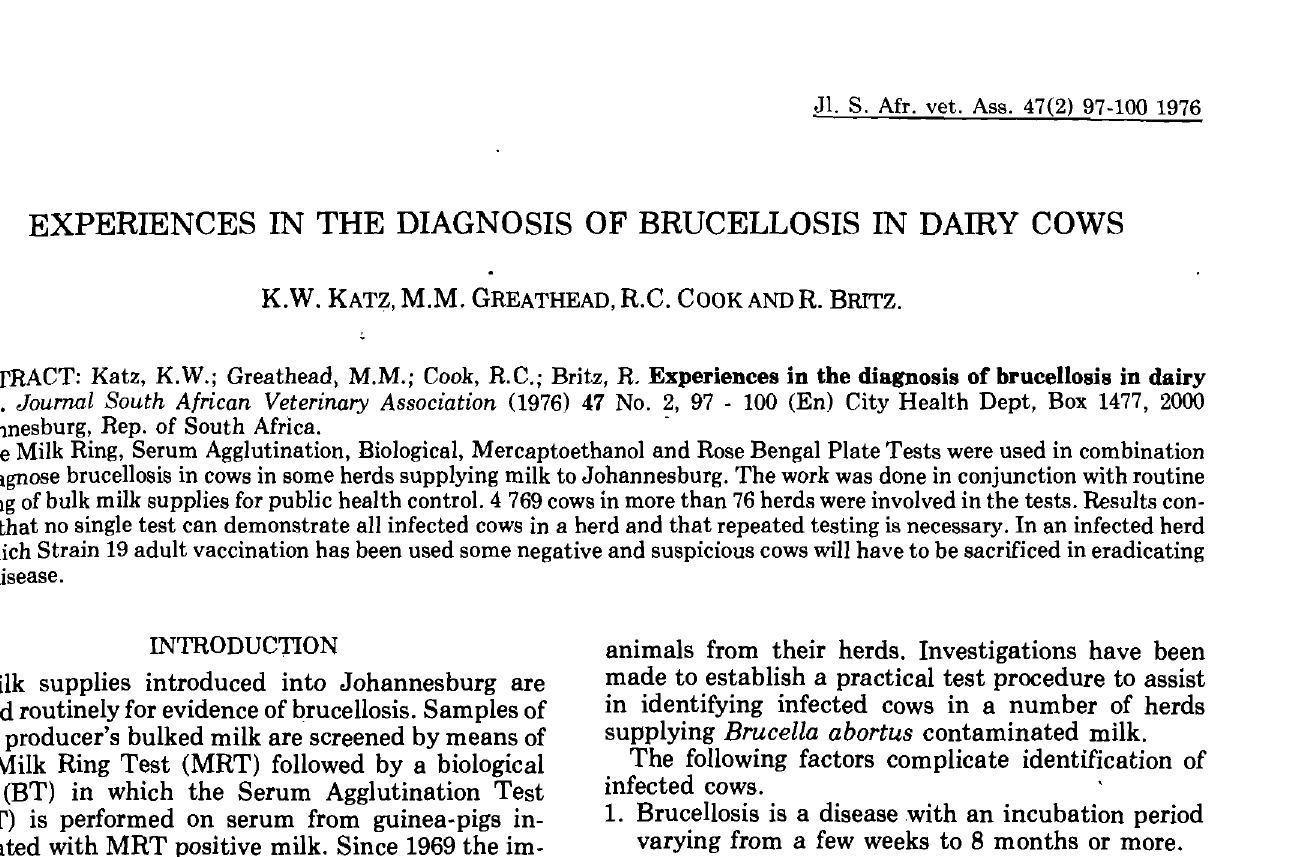
Table 1: INCIDENCE OF BRUCELLA IN RAW HERD MILK